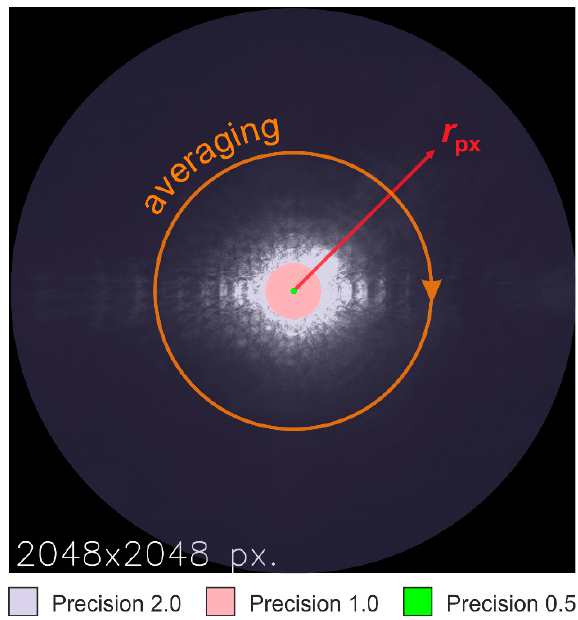
Figure 9. Illustration of the averaging process. The signals of all those pixels having the same distance r px (red coordinate axis) to the laser spot center are averaged (depicted by the circular arrow in orange color) in order to find the radial irradiance distribution. Colored disks, overlaid to the camera image, depict areas where different rounding precisions were applied. The camera image was taken using the lens Edmund Optics 86410 ( 𝜆 = 488 nm , 𝐹 = 2.8 , setting no. 8).